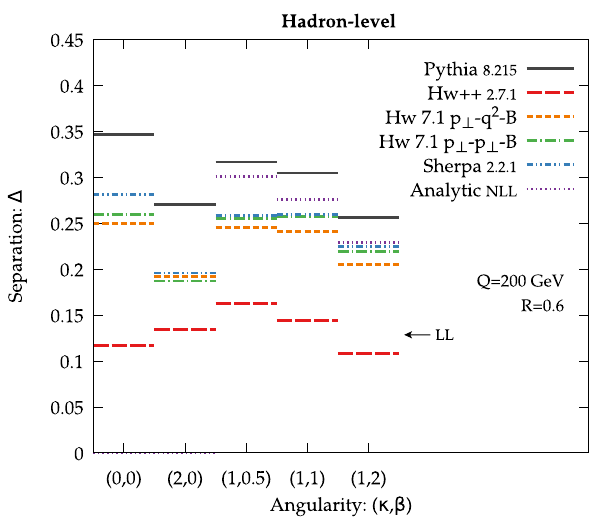
Fig. 14 Classifier separation (cid:12) for the five angularities, determined fromthevariousgeneratorsathadronlevelforanidealizedcaseof e + e − collisions.ThefirsttwocolumnscorrespondtoIRC-unsafedistributions (multiplicity and p D ), while the last three columns are the IRC-safe T angularities